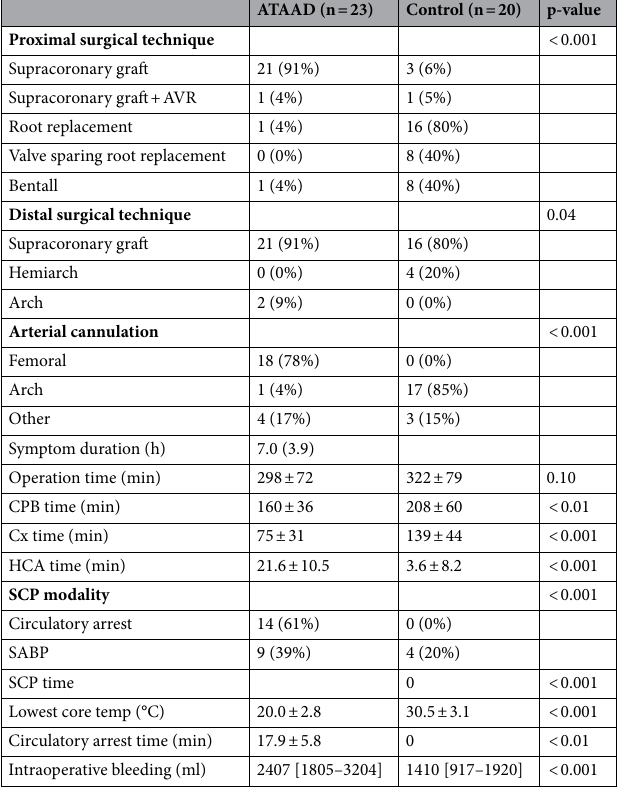
Table 2. Intraoperative characteristics. Values are expressed as numbers (%) , mean ± SD or median [IQR]. ATAAD acute aortic dissection, AVR aortic valve replacement, CPB cardiopulmonary bypass, Cx